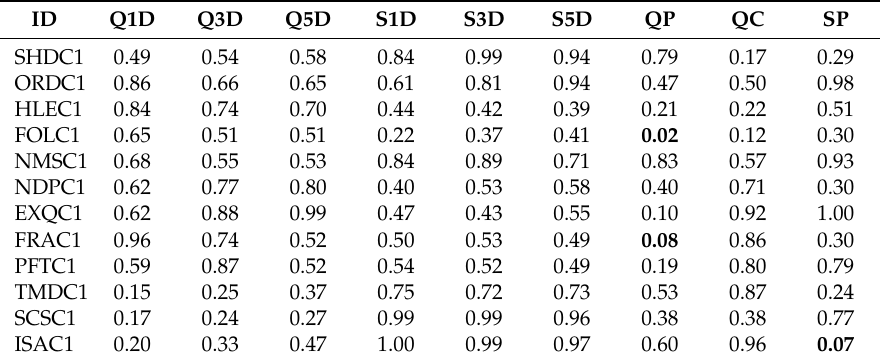
Table 7. p -Value of estimated trend slope of runoff indices via linear regression 1